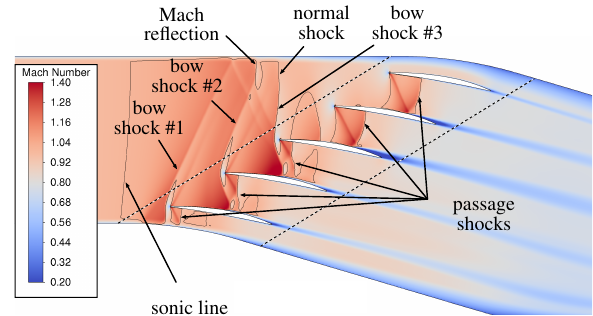
Fig. 5 . Mach number contours of the region in the channel mid- plane around the cascade with the marked main flow features.